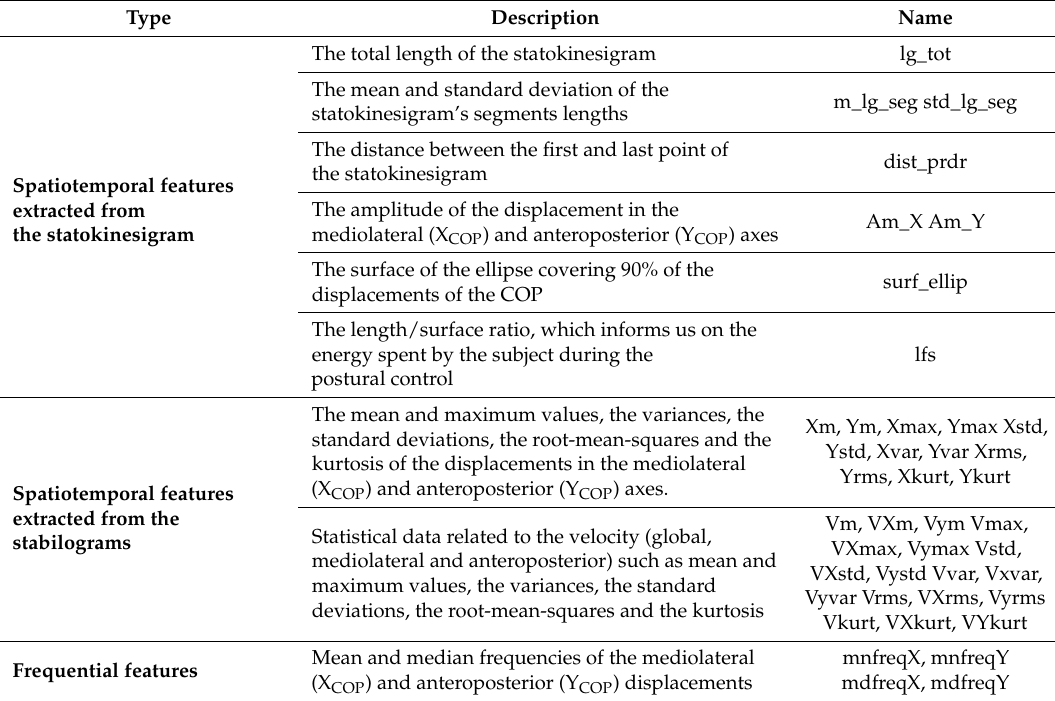
Table 2. List of the features extracted from the COP recordings (insole only).